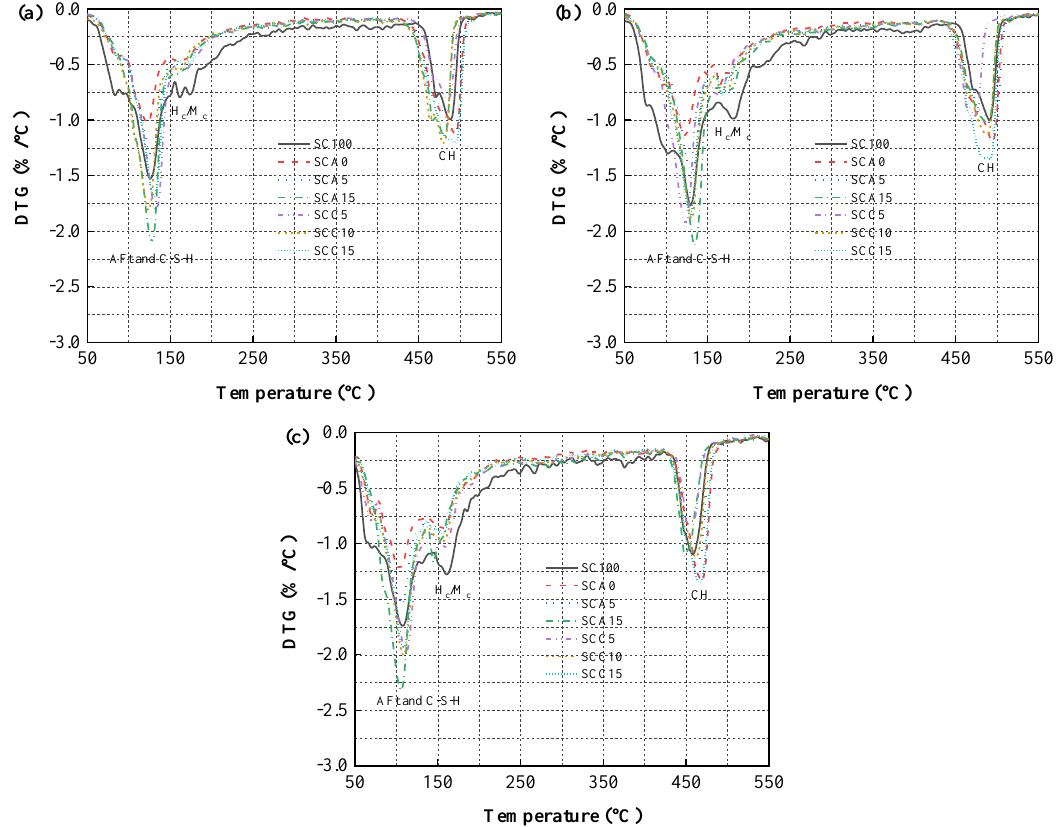
Figure 11. Differential thermogravimetry (DTG) curves of blended binder pastes at hydration times of ( a ) 3 days, ( b ) 7 days, and ( c ) 28 days.